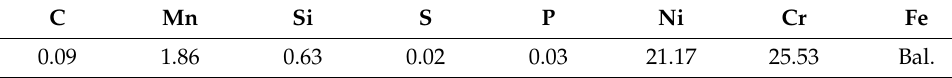
Table 1. Chemical composition of F310H stainless steel (wt.%).